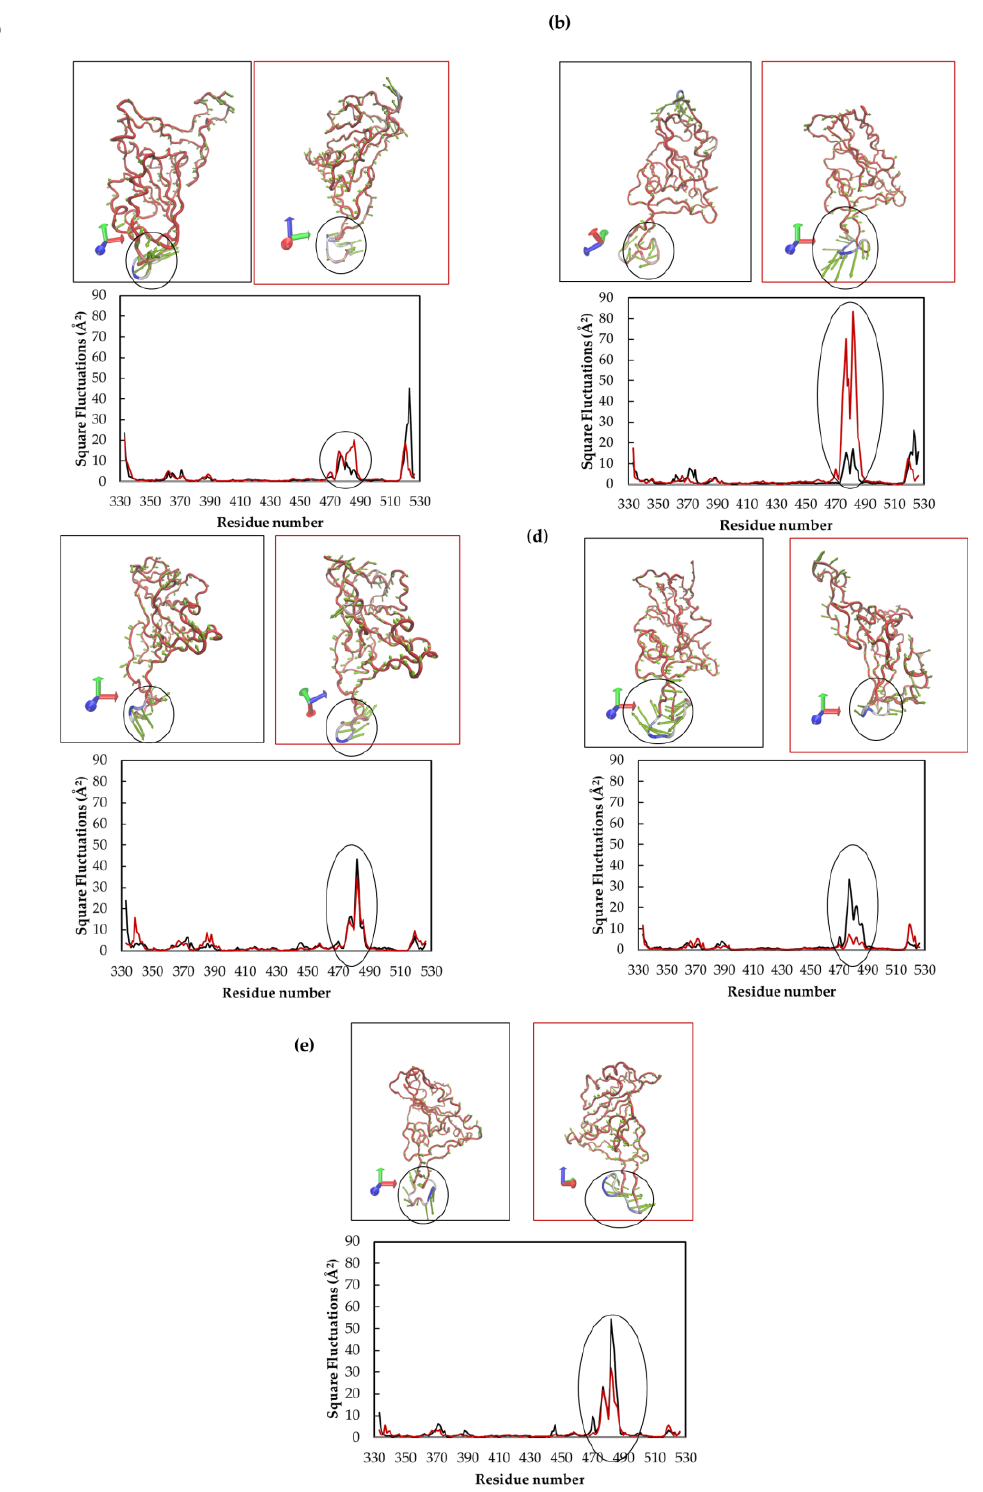
Figure 9. PCA mode 1 and square fluctuations, performed with ProDy application, for: ( a ) RBD, ( b ) GA reference molecule, ( c ) OA5 , ( d ) MA4 and ( e ) UA2 derivatives. All diagrams were constructed using NMWiz plugin in VMD. T475-P487 is marked by a circle. Black representation corresponds to replica 1, and red corresponds to replica 2.